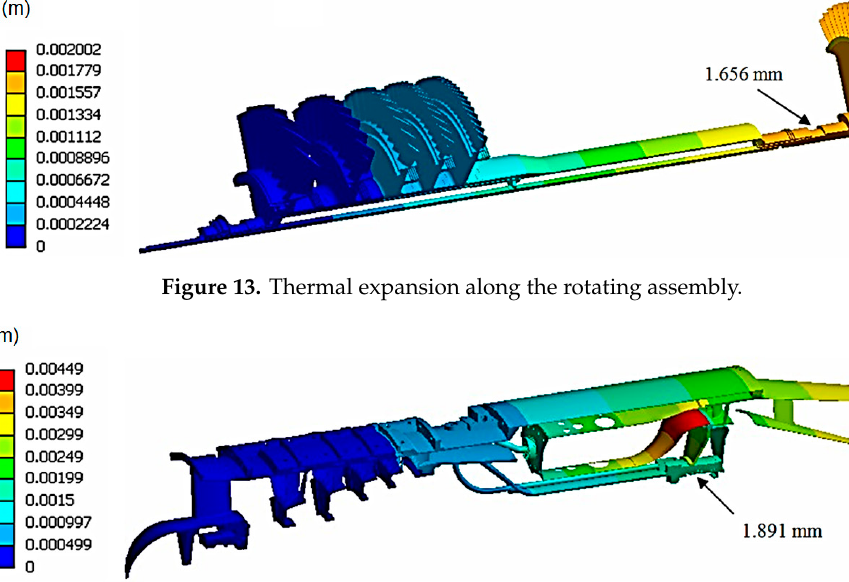
Figure 14. Thermal expansion along the static assembly.